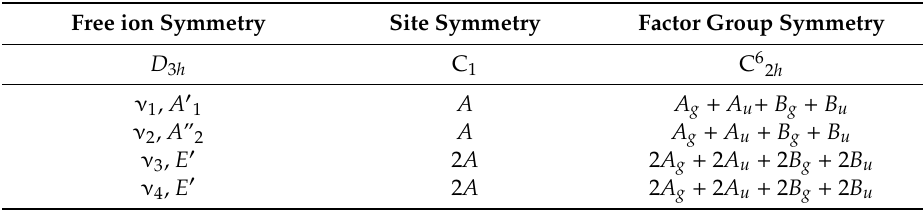
Figure 8. The IR absorption spectra of YAl 3 (BO 3 ) 4 in the range of stretching vibration of BO 3 triangles in comparison with calculated wavenumbers (vertical lines) of IR-active vibrations in trigonal (R32) and hypothetical monoclinic (C2 / c) structures. Table 4. Correlation diagram of internal vibrations of the BO 33 − in case of hypothetical monoclinic structure of the YAB.